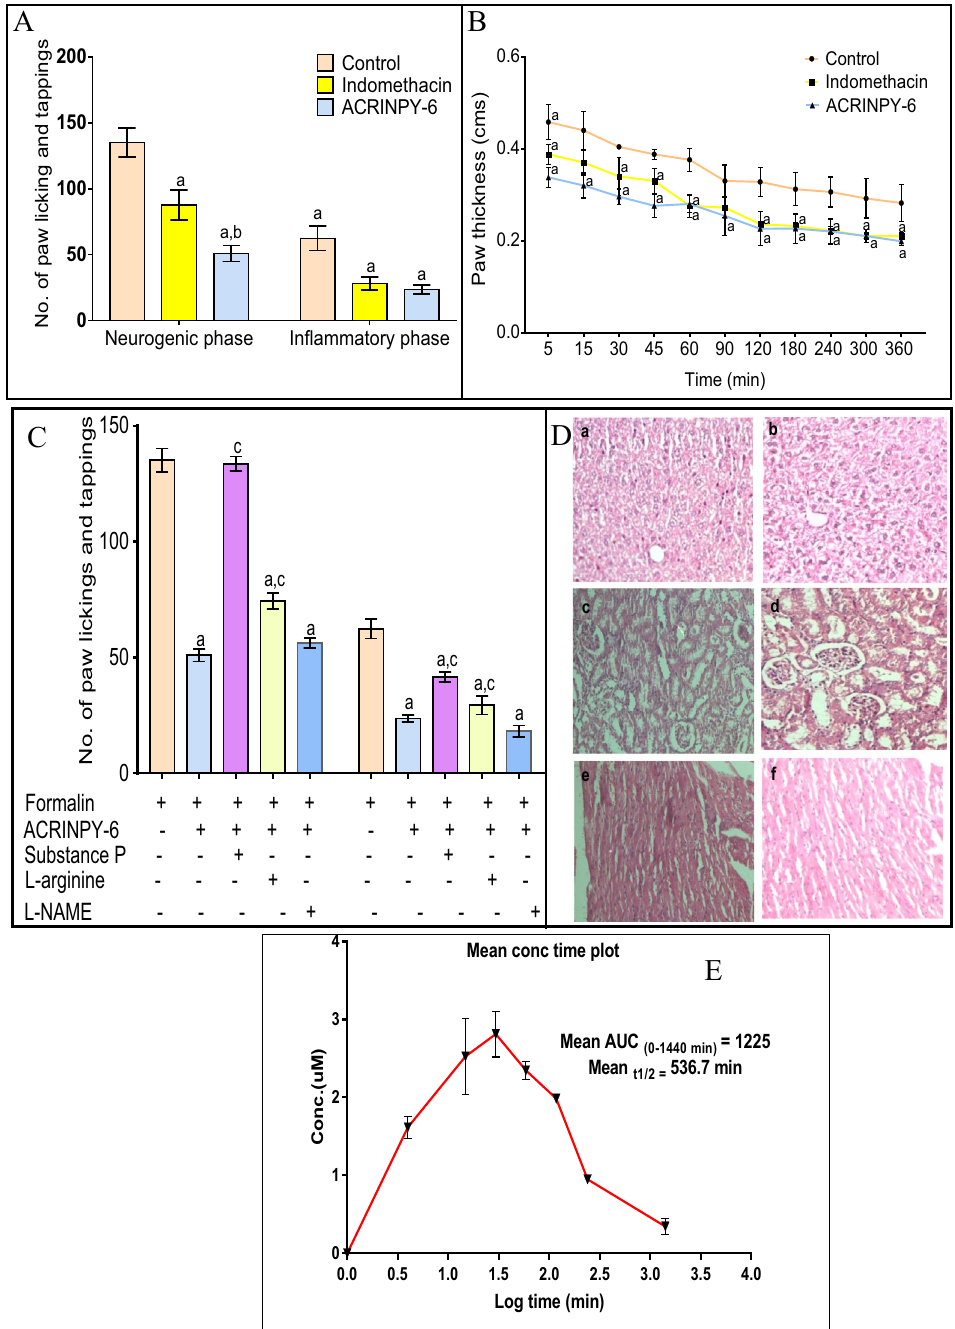
Figure 7. Effect of compound 1 on ( A ) formalin induced flinchings in neurogenic and inflammatory phases in mice, ( B ) paw thickness in carrageenan induced paw edema, ( C ) modulation of the analgesic effect of compound 1 by pre-treatment with substance P, L-arginine and L-NAME. All values are expressed as mean ± S.E.M. Statistical differences were determined by 2-way ANOVA followed by Tukey’s test. a p < 0.05 vs. control, , b p < 0.05 vs. Indomethacin, c p < 0.05 vs. compound 1 . ( D ) Photomicrographs of hematoxylin–eosin (H & E) stained sections of (a) control liver, (b) 1 (2000 mg/kg) treated liver, (c) control kidney, (d) 1 treated kidney, (e) control myocardium, (f) 1 treated myocardium. All pictures were taken with light microscope at × 20 × magnifcation. ( E ) Pharmacokinetic profile of 1 indicated by concentration time